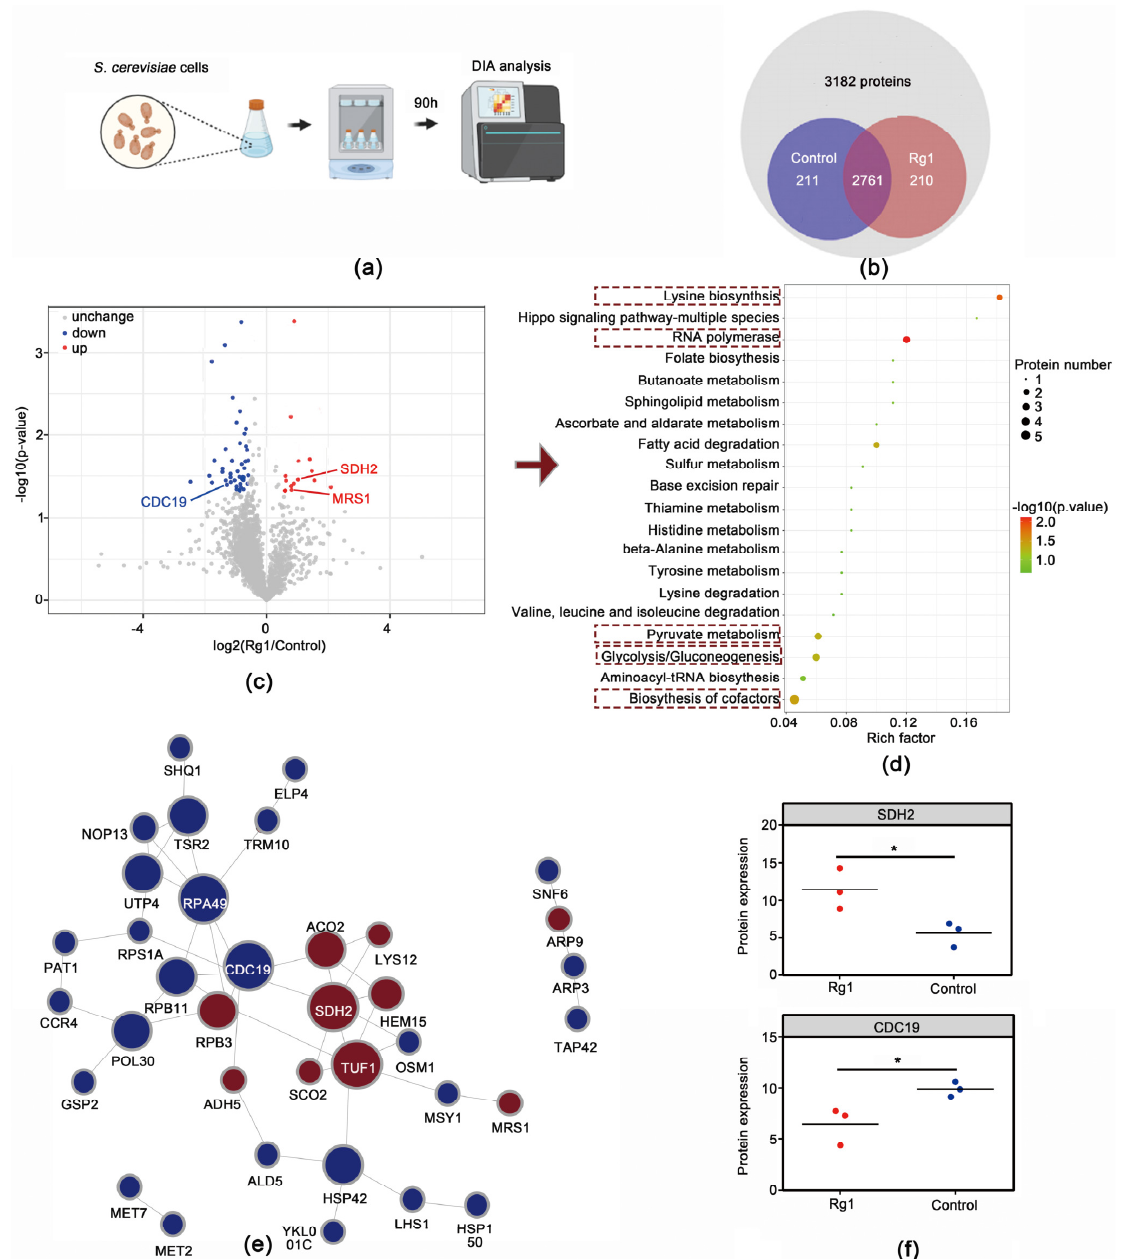
Figure 6. Rg1 treatment altered the proteomic profile of S. cerevisiae cells. ( a ) Schematic diagram of the Data-Independent Acquisition proteomic analysis preparation process. ( b ) Venn diagram of proteins enriched in yeast cells. ( c ) Volcano plot of protein expression changes. Control vs. Rg1, “Control” was untreated, and “Rg1” was treated from 16 to 90 h. Differences were considered statistically significant at p < 0.05. ( d ) The top 20 enriched Kyoto Encyclopedia of Genes and Genomes (KEGG) pathways. The significance of the KEGG pathways is indicated by the intensity of the red color. ( e ) Protein–protein interaction network analysis of the effect of Rg1 of S. cerevisiae . The node color indicates an increase (red) to decrease (blue) of the protein interaction counts. The size of the circle represents the number of proteins interacting with other proteins in the network. ( f ) Changes in expression levels of CDC19 and SDH2 differential proteins (the data were scaled down based on proteomics output data, CDC19 shows data reduced 1,000,000-fold, SDH2 shows data reduced 10,000-fold). Protein levels were quantified and analyzed by one-way analysis of variance. Data are expressed as the mean ± SD; n = 3. Compared with untreated controls, * p <